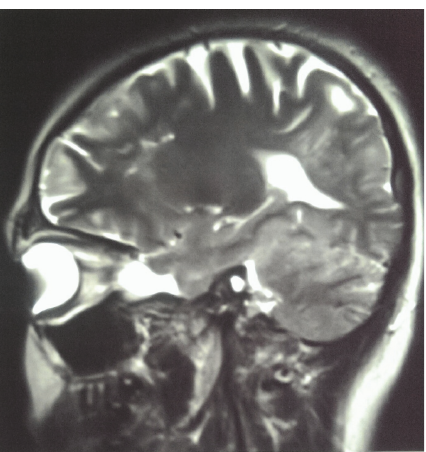
Figure 1: T2 weighted MRI of the brain in sagittal section, showing low-signal subependymal lesion beneath lateral ventricles along with bilateral supratentorial subcortical flair hyperintense signal